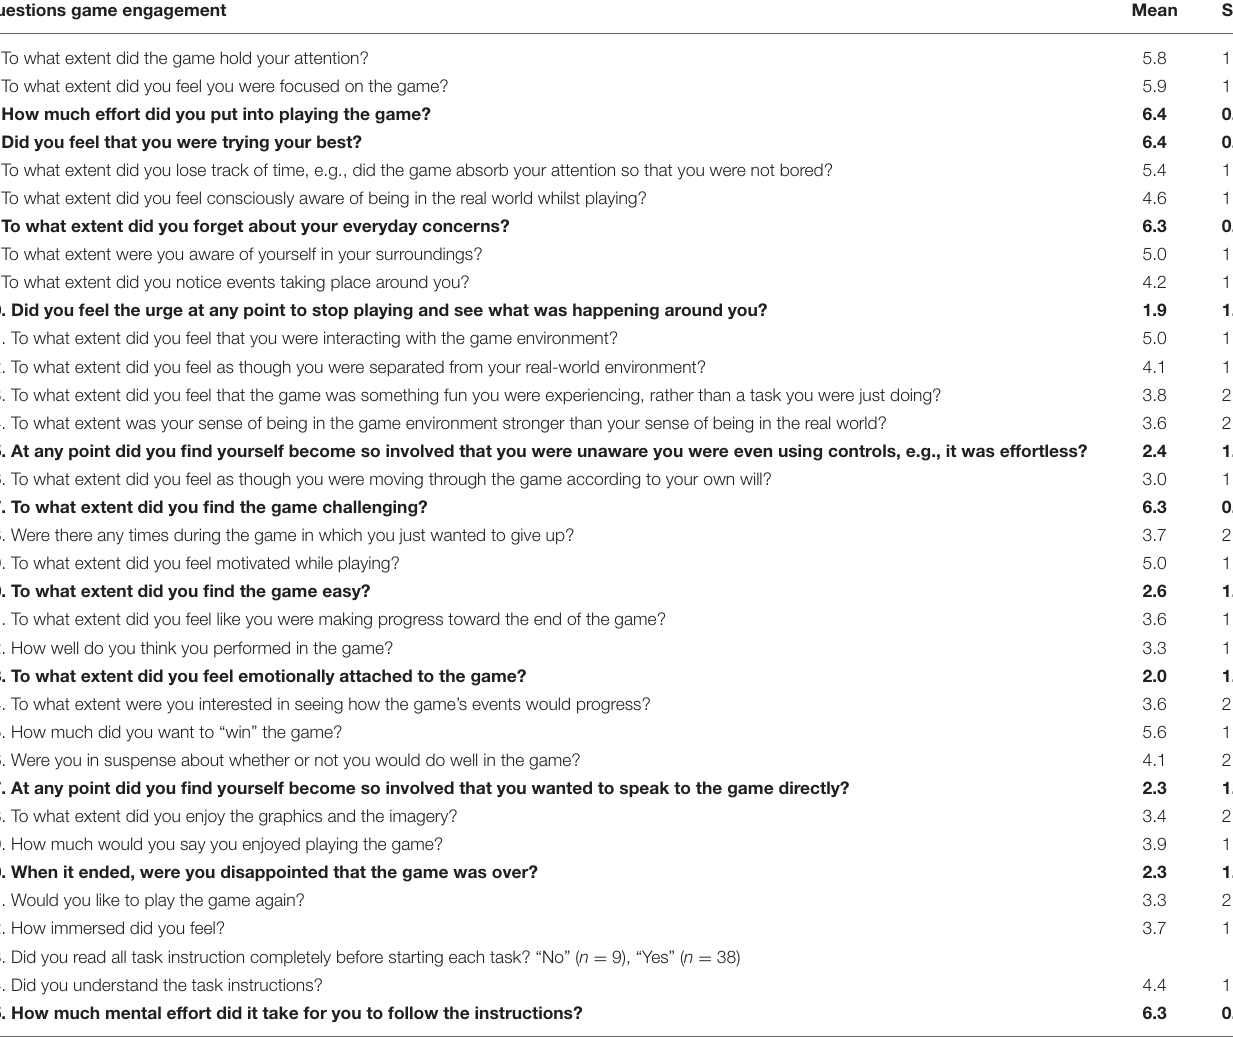
TABLE 3 | Self-reported commitment with the